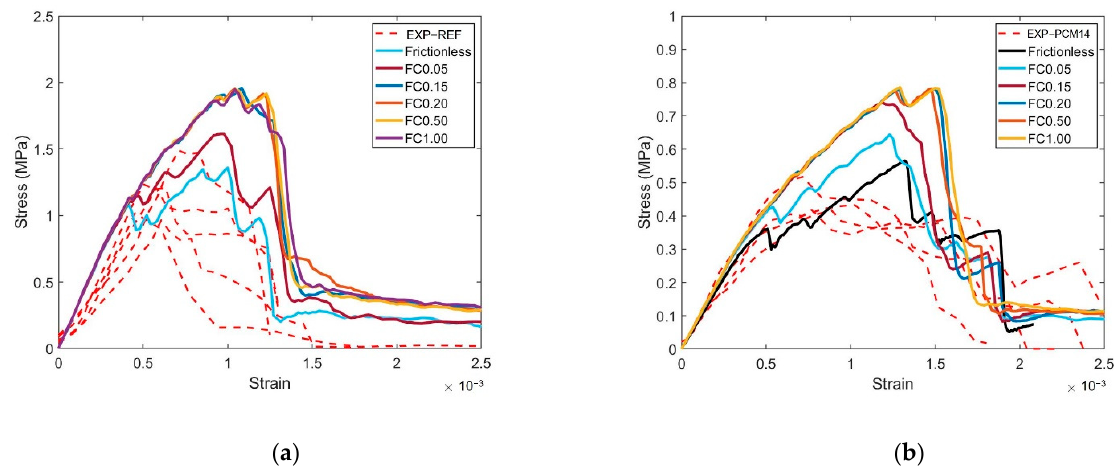
Figure 29. Influence of the friction coefficient (FC) on the simulated in-plane stress–strain curves of ( a ) R7-REF and ( b ) R7-PCM14; note that the y-axes of the two figures are different.